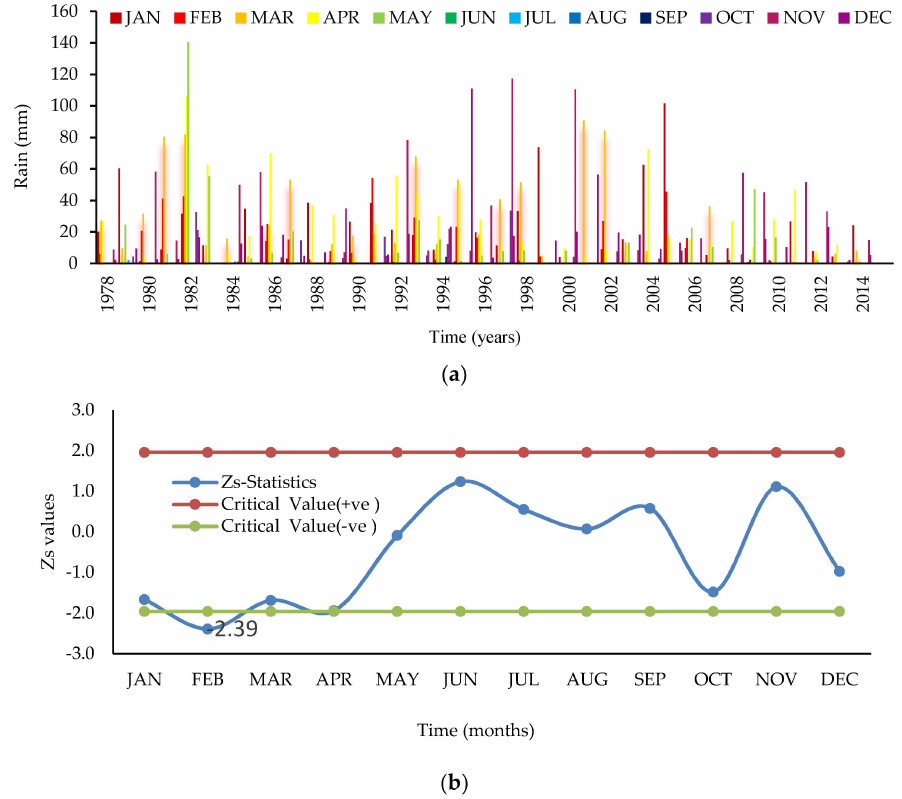
Figure 4. Rainfall over the Qassim region (observed data): ( a ) monthly rainfall; and ( b ) trend analysis for rainfall